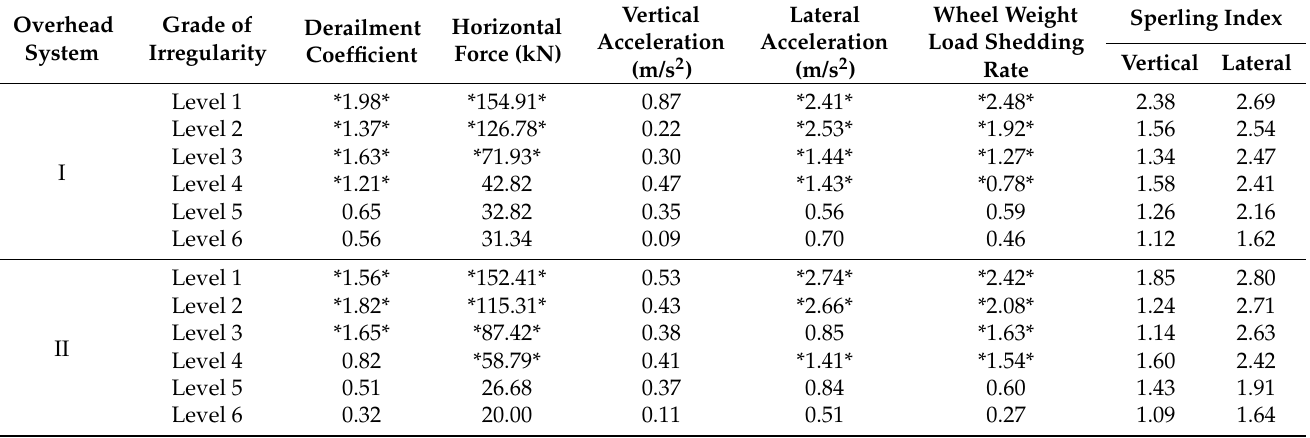
Table 7. The dynamic response of the train under various track irregularity grades. (“*” is displayed for any data that do not meet the